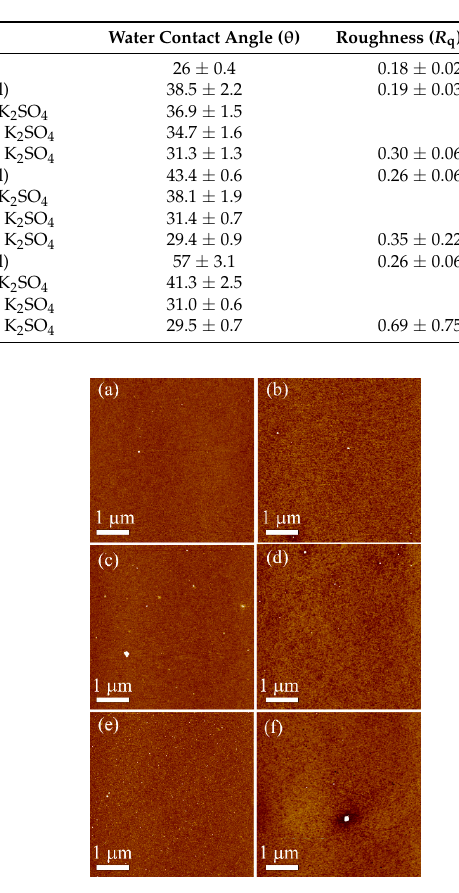
Figure 4. AFM topography images recorded for: ( a ) 1% APTES, ( b ) 1% APTES_PEG/0.6 M K 2 SO 4 /60 °C, ( c ) 2% APTES, ( d ) 2% APTES_PEG/0.6 M K 2 SO 4 /60 °C, ( e ) 4% APTES, and ( f ) 4% APTES_PEG/0.6 M K 2 SO 4 /60 °C (OD600nm = 0.48). All z -scales were equal to 5 nm. (Higher resolution images can be seen in Figure